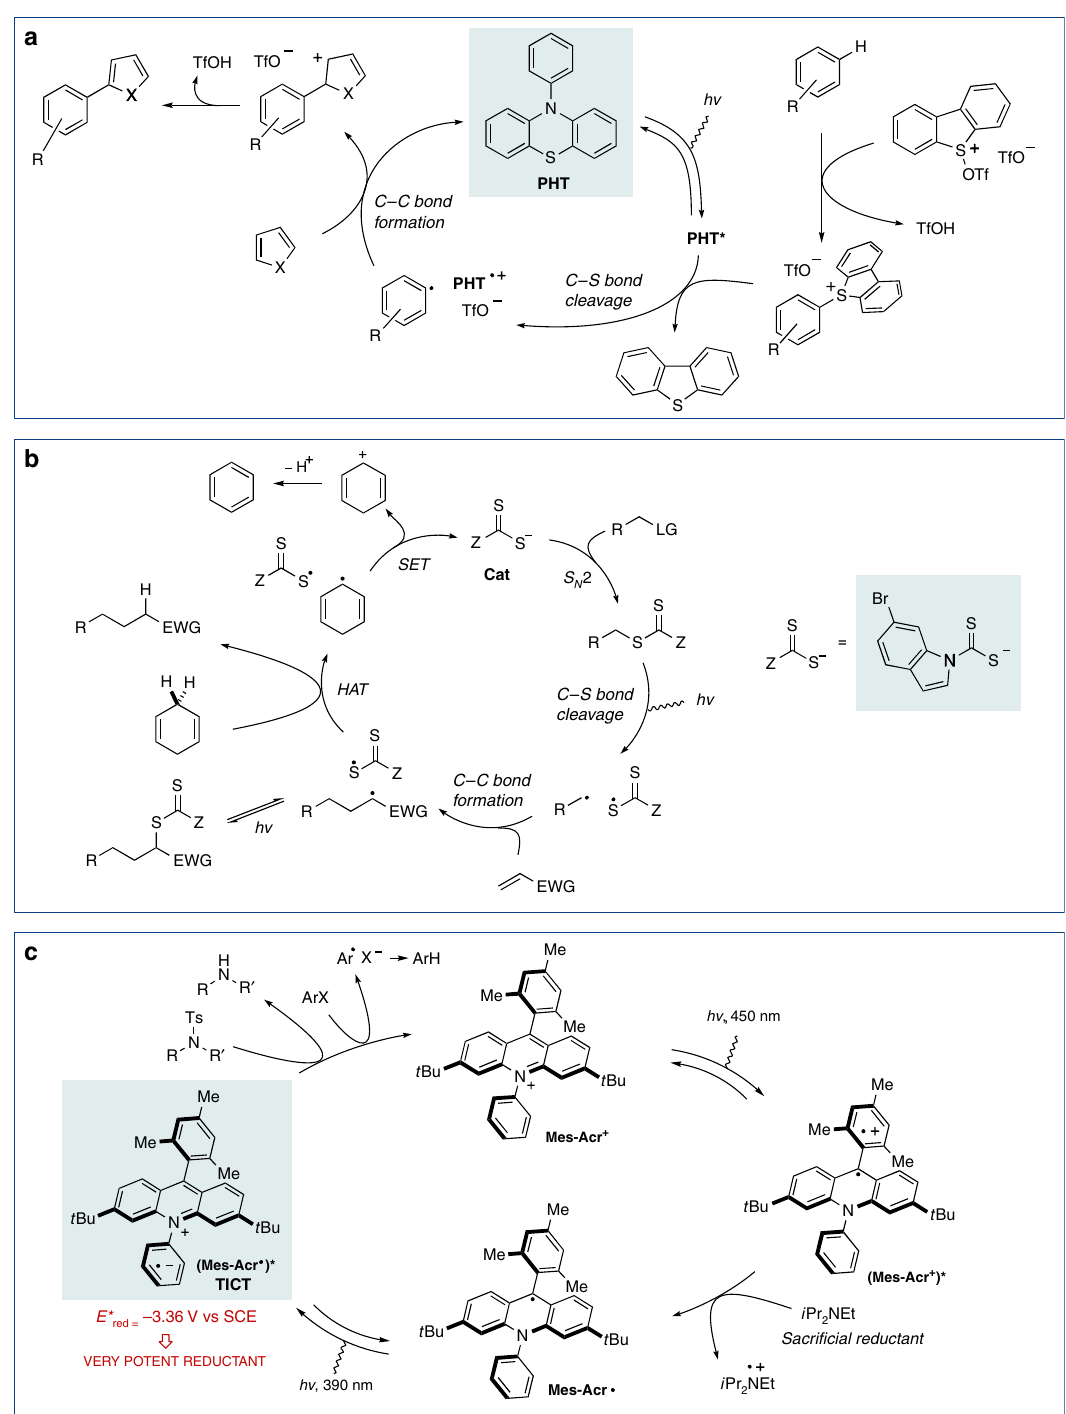
Fig. 2 Selected photoorganocatalytic transformations. a Photoorganocatalytic oxidative cross-coupling of arenes and heteroarenes using an interrupted Pummerer rearrangement. b Photoorganocatalytic generation of free alkyl radicals: Alkylation of electrophilic alkenes. LG leaving group, SET single electron transfer, HAT hydrogen atom transfer, EWG electron-withdrawing group. c Photoorganoatalytic reductions mediated by an excited neutral acridine radical. TICT twisted intramolecular